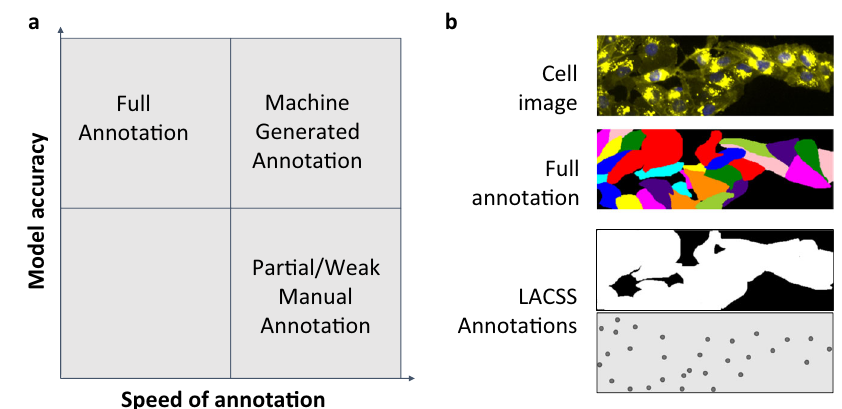
Fig. 1 Comparison of various training data annotations for single-cell segmentation models. a Diagram illustrating the con fl icting goals of faster annotation and higher model accuracy, and how experimentally acquired annotations offer a better compromise. b Examples of annotations. The top image shows a representative microscopy image of cells. The second row shows the corresponding full annotation of single-cell segmentations, which is expensive to generate. The bottom two rows showed two types of incomplete annotations that can potentially be generate programmably: (1) image-level segmentation, which labels the pixels of all cells in the image, and (2) location-of-interests annotation, which a subtype of the point annotation that denotes rough locations of individual cells.